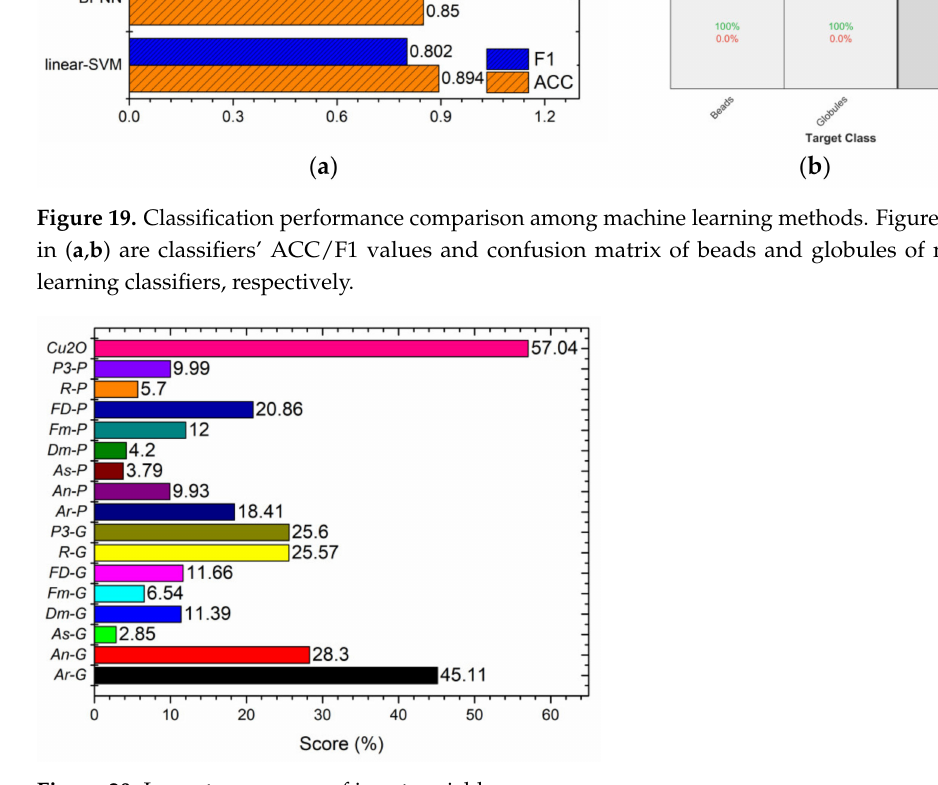
Figure 20. Importance scores of input